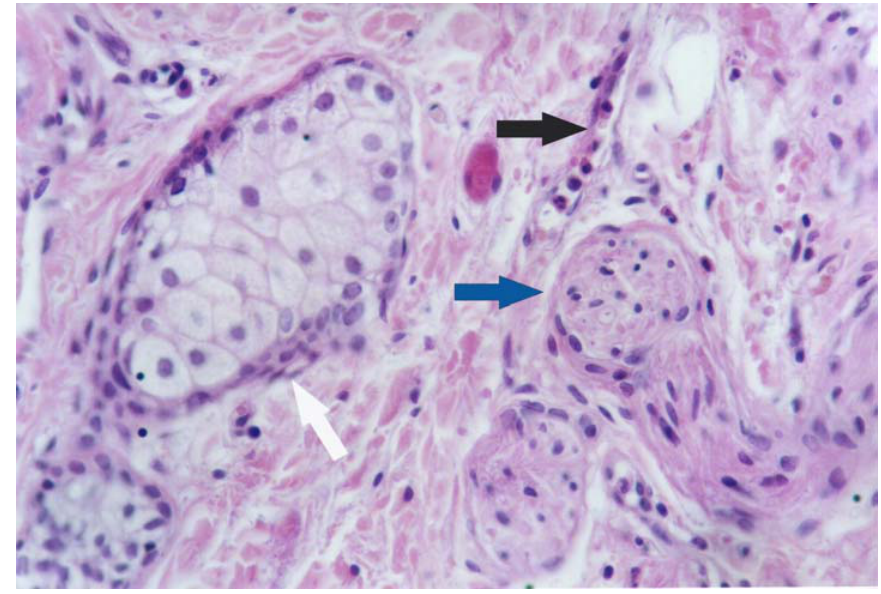
FIGURE 5 . High-power microscopy. Details of cystic capsule exhibiting sebaceous glands (white arrow), nerve bundle (blue arrow), and blood vessels (black arrow). (H&E, original magnification X 100). dermal appendages hair follicles, sebaceous glands, nerve bundle, and associated erector pili muscles (Fig 3). Connective tissue is generally free of inflammation. Diagnosis was dermoid